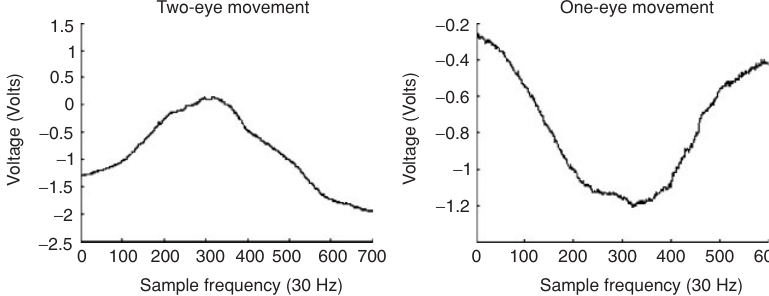
Figure 22 Using the EOG to detect one-eye (one electrode at nose and one at temple) and two-eye movement (electrodes at each temple). (The subject moved his/her eye from one extreme to another and moved